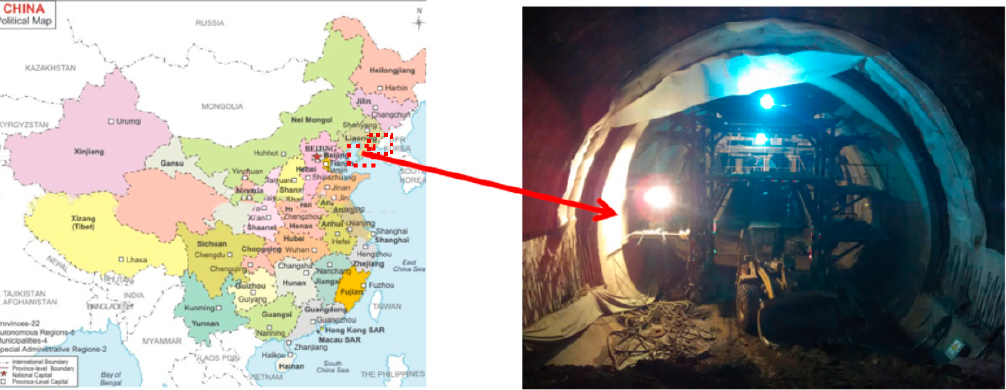
Figure 2. The location of the Chenjiadian tunnel.